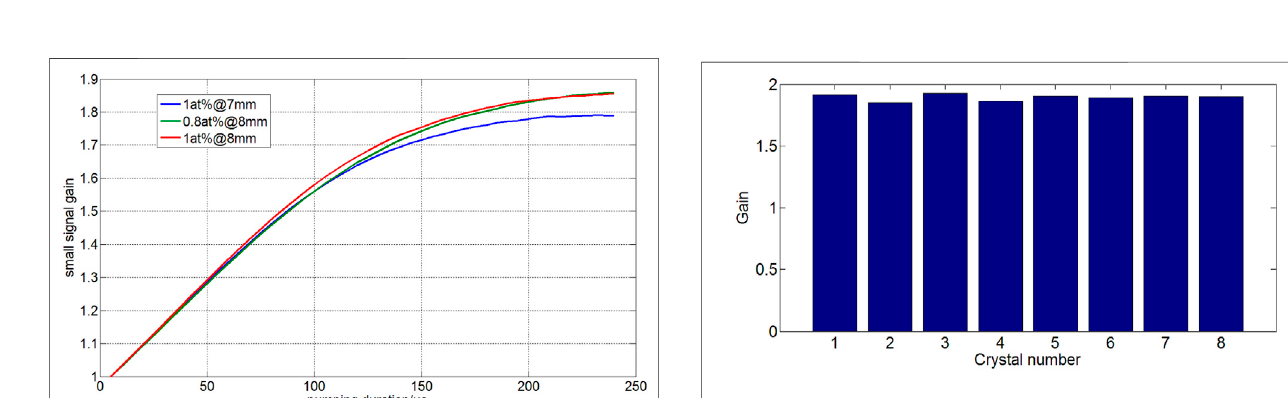
FIGURE 6 | Small signal gain of each ampli fi er module.